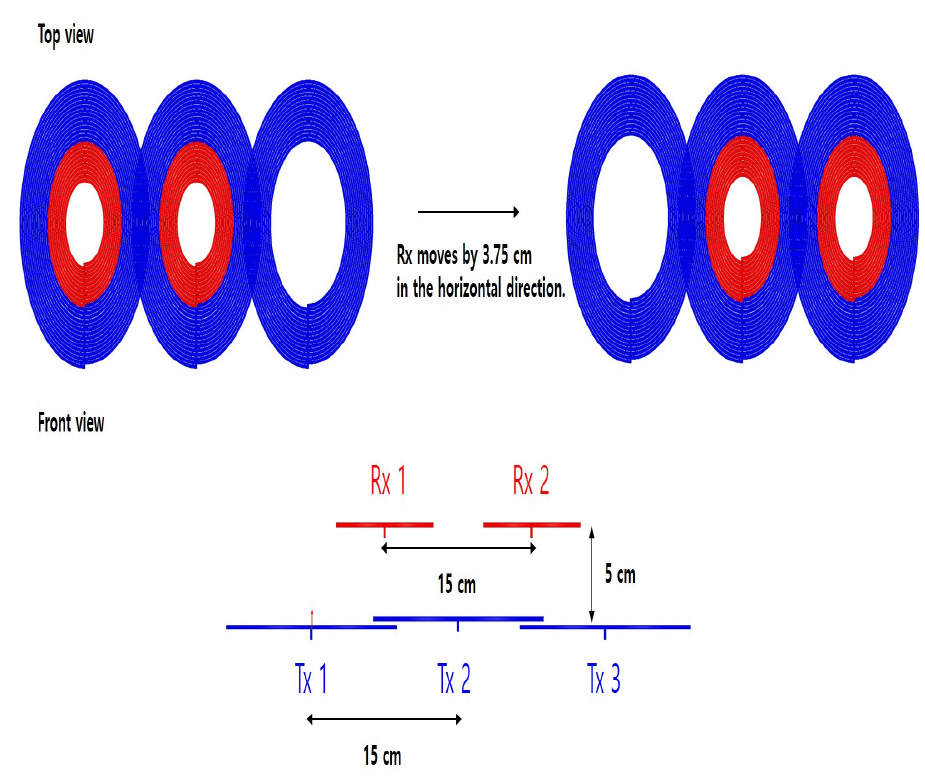
Figure 3. Simulation model using Tx coils with an inner diameter of 10 cm and Rx coils with an inner diameter of 5